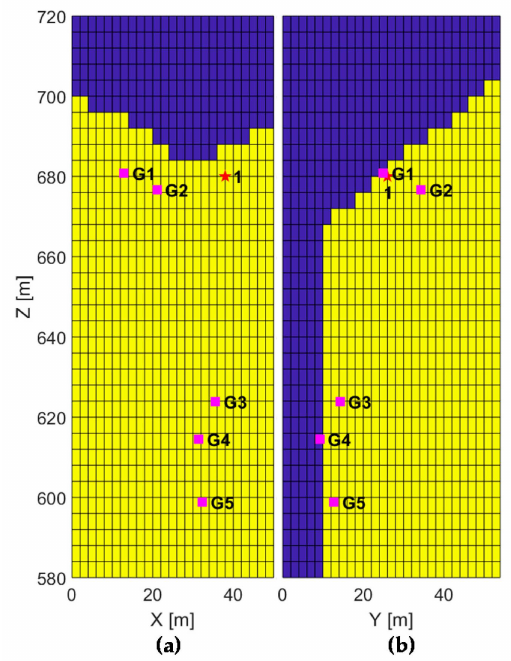
Figure 11. Location results for Rockfall event 6 (Summit debris noise) presented on vertical slices in the front view ( a ) and side view ( b ). The blue area is the air, and the yellow area is the rock mass. Pink squares indicate the five 3C geophones projected on the slice. Red stars indicate the event locations projected on the slice and numbers are used to order the signals according to the arrival